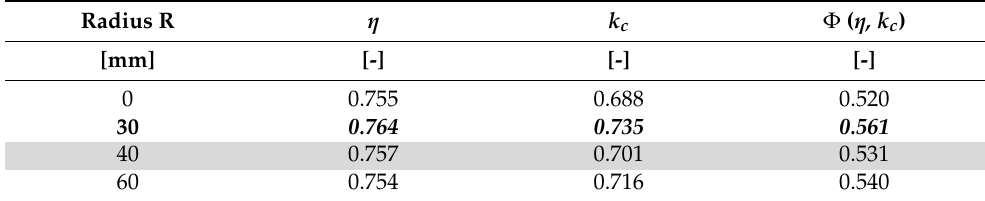
Table 10. The effect of the radius of a return vane.